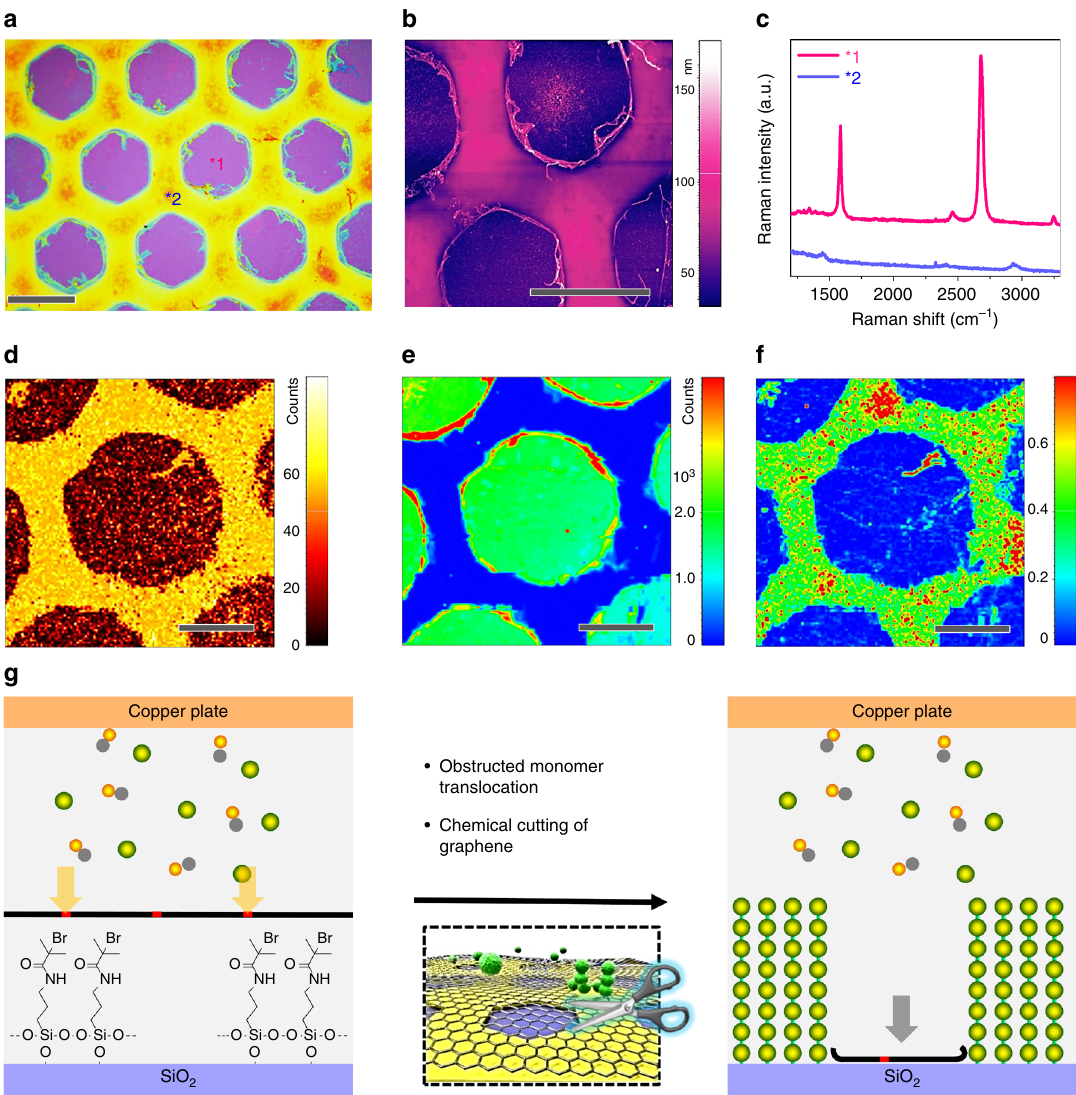
Fig. 4 Translocation of SPMA through graphene driven by SI-CRP. a Optical microscopic image. b AFM topographic image. c Representative Raman spectra of regions ∗ 1 and ∗ 2 marked in b . d Raman mapping with the integrated intensity from PSPMA in the range of 2927 cm − 1 . e Intensity Raman mapping of graphene 2D band. f Raman mapping of integrated intensity ratio of I D / I G of graphene. g Scheme of the experimental set-up and the chemical cutting of graphene by the translocation of SPMA induced by SI-CRP. Scale bars in a , b : 40 µ m; in d – f : 20